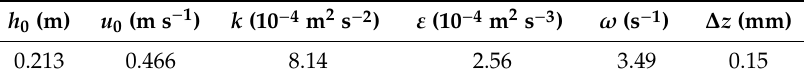
Figure 2. Computational domain of two-dimensional open-channel flow over single dune. Table 2. Boundary conditions of turbulent models.